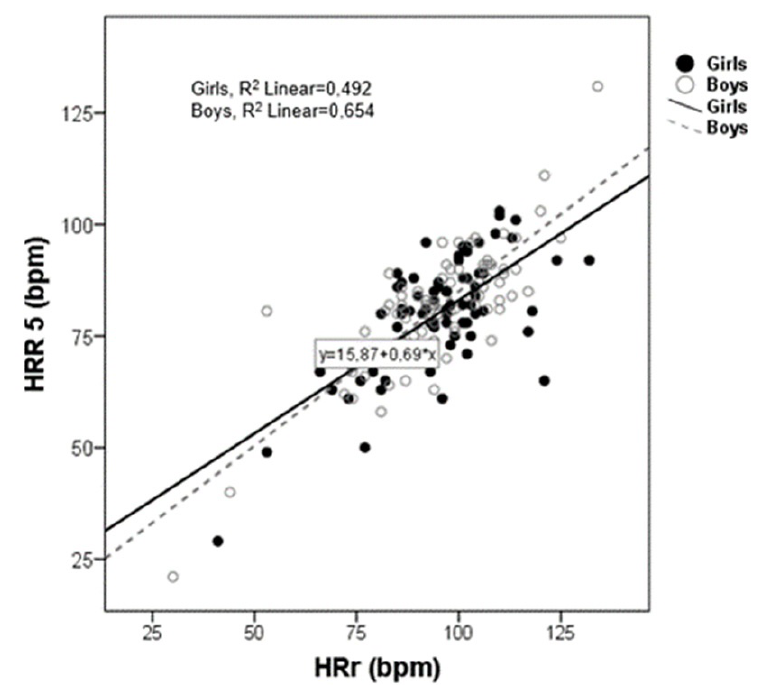
Figure 2. Scatter plot between heart rate reserve (HRr) and heart rate recovery (HRR) post exercise (5 min).